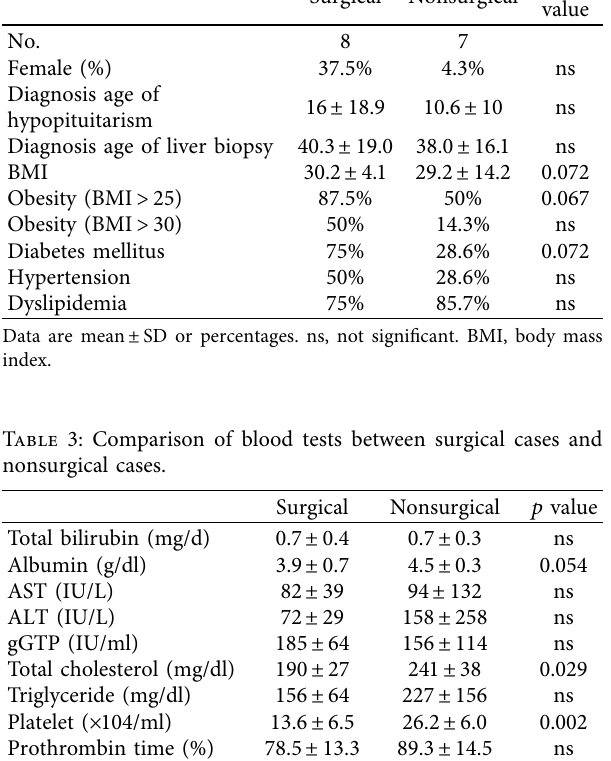
Table 4: Comparison of liver pathological findings between sur- gical cases and nonsurgical